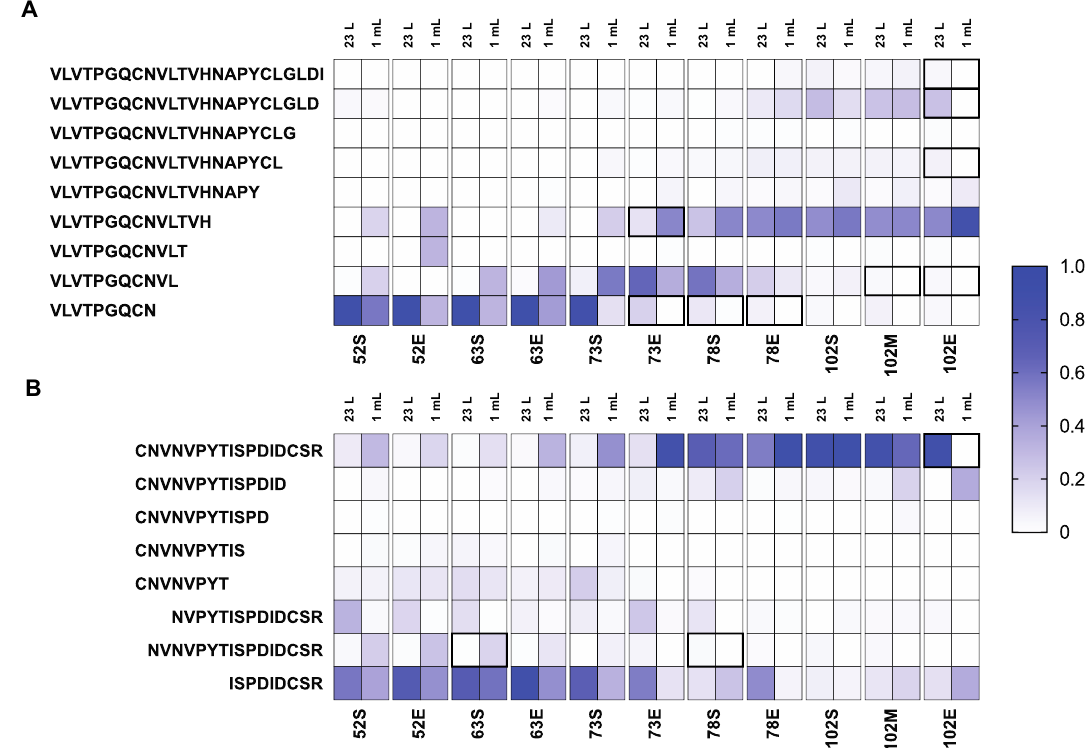
Figure 3. Proteolytically clipped peptide abundance profiles are similar between a 23 L Braumeister and a 1 mL micro-scale mash. ( A ) Normalised abundance of full and semi-tryptic peptides of V 122 LVTPGQCNVLTVHNAPYCLGLDI 145 from IAAA in both the Braumeister mash (left columns) and micro-scale mash (right columns). ( B ) Normalised abundance of full and semi-tryptic peptides of K-C 99 NVNVPYTISPDIDCSR 115 -I from NLTP1 in both the Braumeister mash (left columns) and benchtop micro-scale mash (right columns). Values show mean, n = 3. Bold highlights, statistically significant ( p <